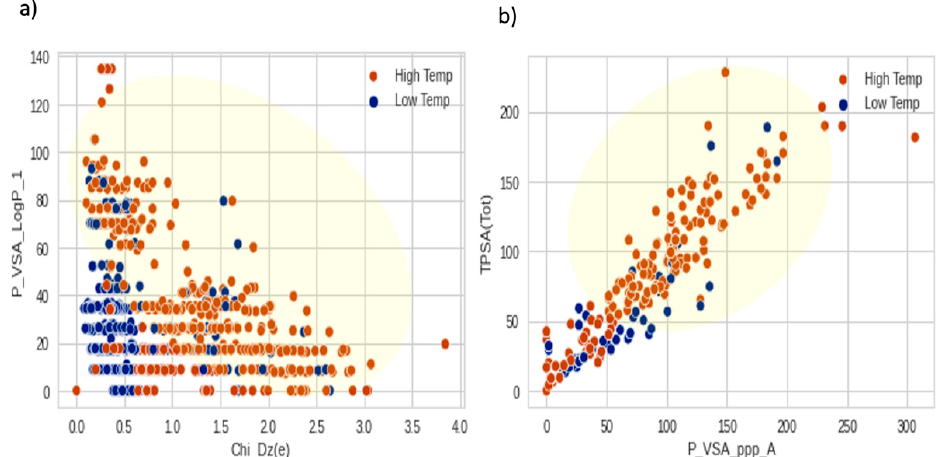
Figure 5. The distribution of the ILs melting points (1253 datapoints) which distinguish the low- ( T m < 273 K) and high-melting ( T m > 273 K) points ILs using the best combination of two molecular descriptors: ( a ) P_VSA_LogP_1 vs. Chi_Dz(e); ( b ) TPSA(Tot) vs. P_VSA_ppp_A. The color of data points indicates the low (blue color) and high (brown color) melting point of the corresponding ILs dataset. The yellow region highlights the high melting point